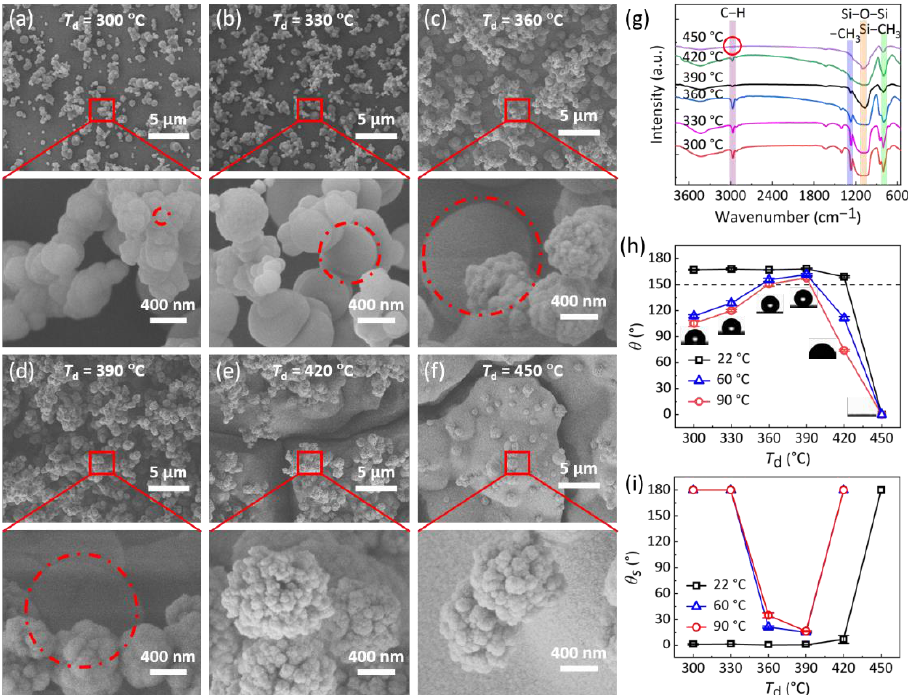
Figure 1. Surface morphology, chemical composition and wettability. ( a – f ) SEM images of surfaces fabricated at 300 °C, 330 °C, 360 °C, 390 °C, 420 °C and 450 °C, respectively. The deposition time was fixed at 3 h. ( g ) FT-IR spectra of the as-fabricated surfaces. ( h , i ) Contact angles ( θ ) and sliding angle ( θ s ) of water droplets with different temperatures on the as-prepared surfaces.